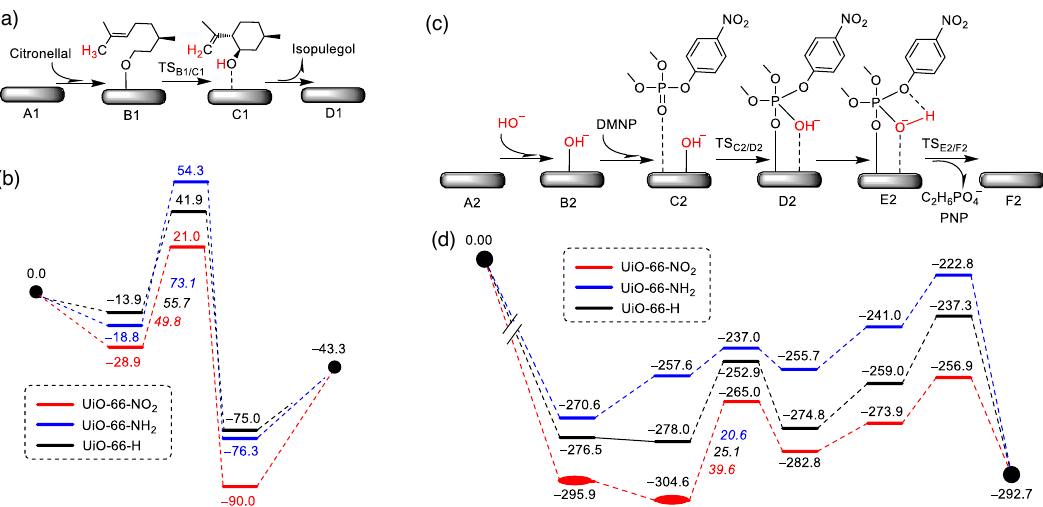
Fig. 3 Mechanisms and kinetics of the UiO-66-X catalyzed reactions obtained by DFT calculations. a , b Mechanisms and corresponding free energy pro fi les for Reactions 1. c , d Mechanisms and corresponding free energy pro fi les for Reactions 2. In b , d , relative free energies are labelled; free energy barriers of the rate-determining steps are shown in italic (energy unit: kJ mol − 1